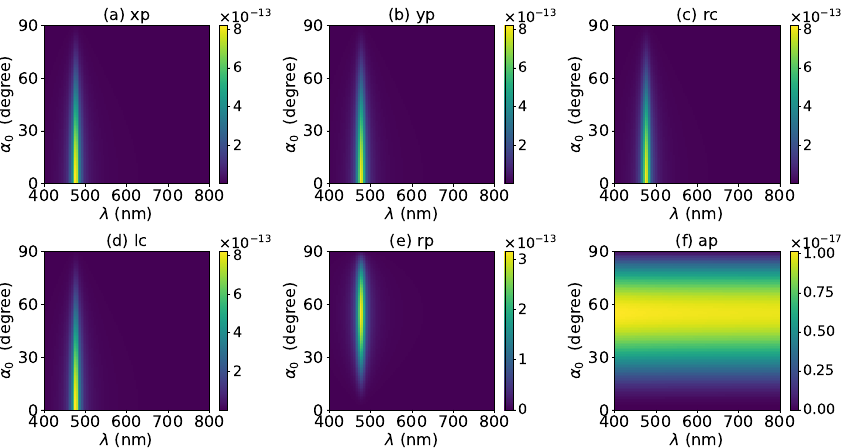
Figure 2. The axial optical force F z of a zeroth-order Bessel beam centered on a graphene-coated gold nanosphere. The layer number is N = 0, which means the particle is a gold nanosphere without graphene coating. Panels ( a – f ) correspond to linear, circular, radial, and azimuthal polarizations, respectively. The titles of panels xp, yp, rc, lc, rp, and ap denote x, y, right circular, left circular, radial, and azimuthal polarizations, respectively.